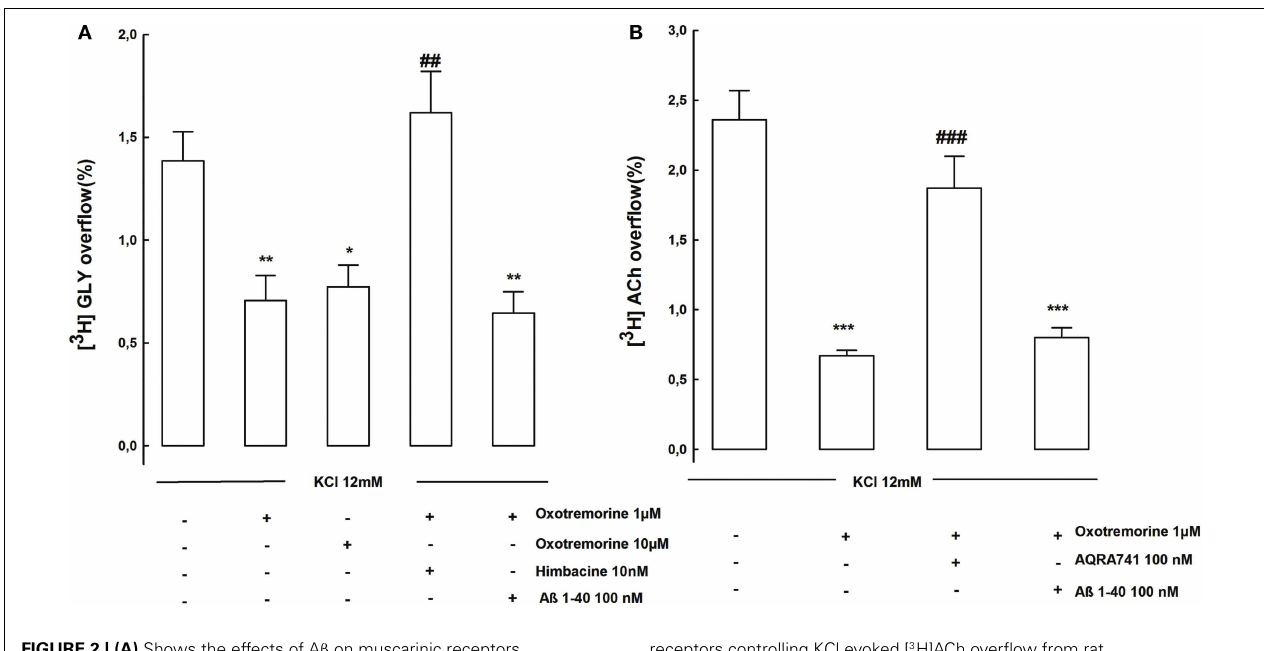
FIGURE 2 | (A) Shows the effects of A β on muscarinic receptors controlling KCl evoked [ 3 H]GLY overflow from rat hippocampal synaptosomes. Data are mean ± SEM of three to six experiments run in triplicate. * p < 0.05; ** p < 0.01 versus KCl evoked [ 3 H]GLY overflow; ## p < 0.01 versus KCl plus oxotremorine (1 µ M)-evoked [ 3 H]GLY overflow. (B) Shows the effects of A β on muscarinic